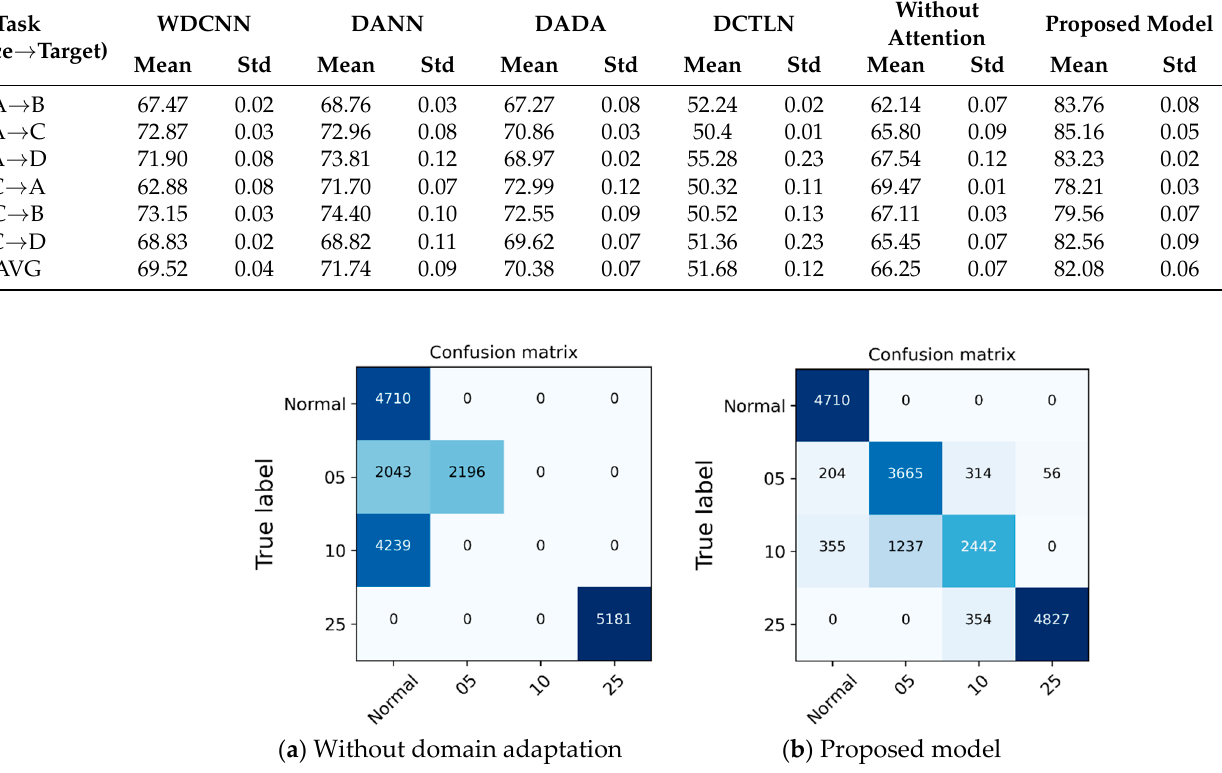
Figure 11. The confusion matrix of the classification results of the proposed model or without attention model.